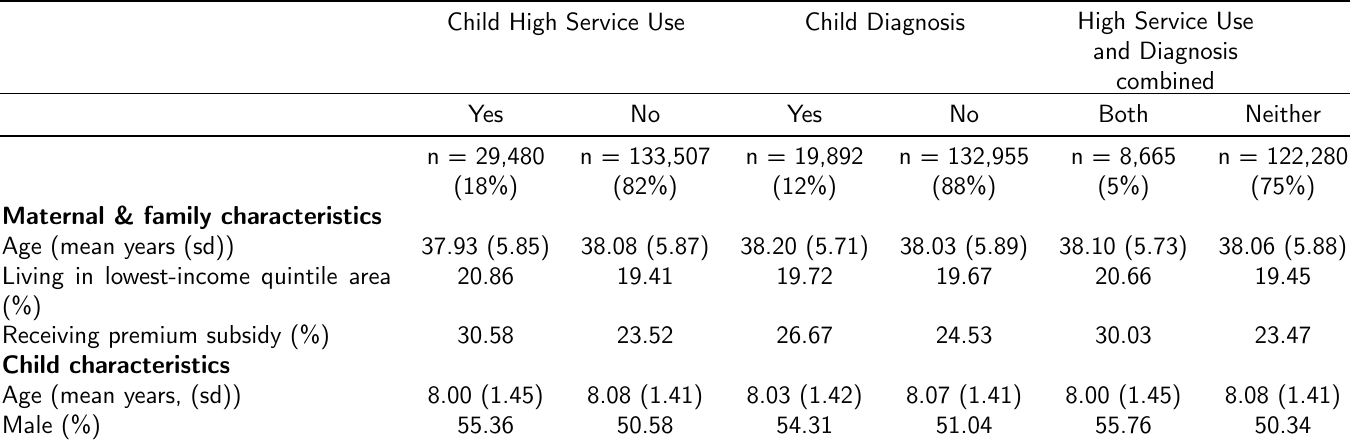
Table 1: Family, maternal, and child characteristics of the sample (N=162,847) across child health groupings